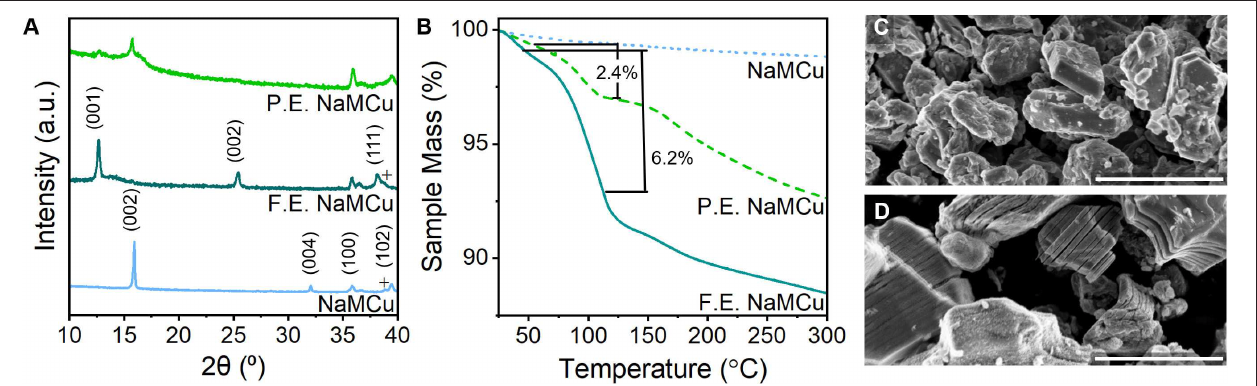
FIGURE 3 | Structural characterization of expanded NaMCu materials. (A) Powder XRD shows the complete transformation of the F.E. material into the hydrated phase, while the P.E. material contains both the hydrated phase and residual P2 phase. (B) TGA shows that both F.E. and P.E. NaMCu materials lose a significant amount of water with increasing temperature. SEM of the (C) pristine NaMCu powder and (D) F.E. NaMCu powder shows that the expanded particles retain their initial hexagonal morphology and particle size but are now expanded along the layers. Scale bar 3 µ